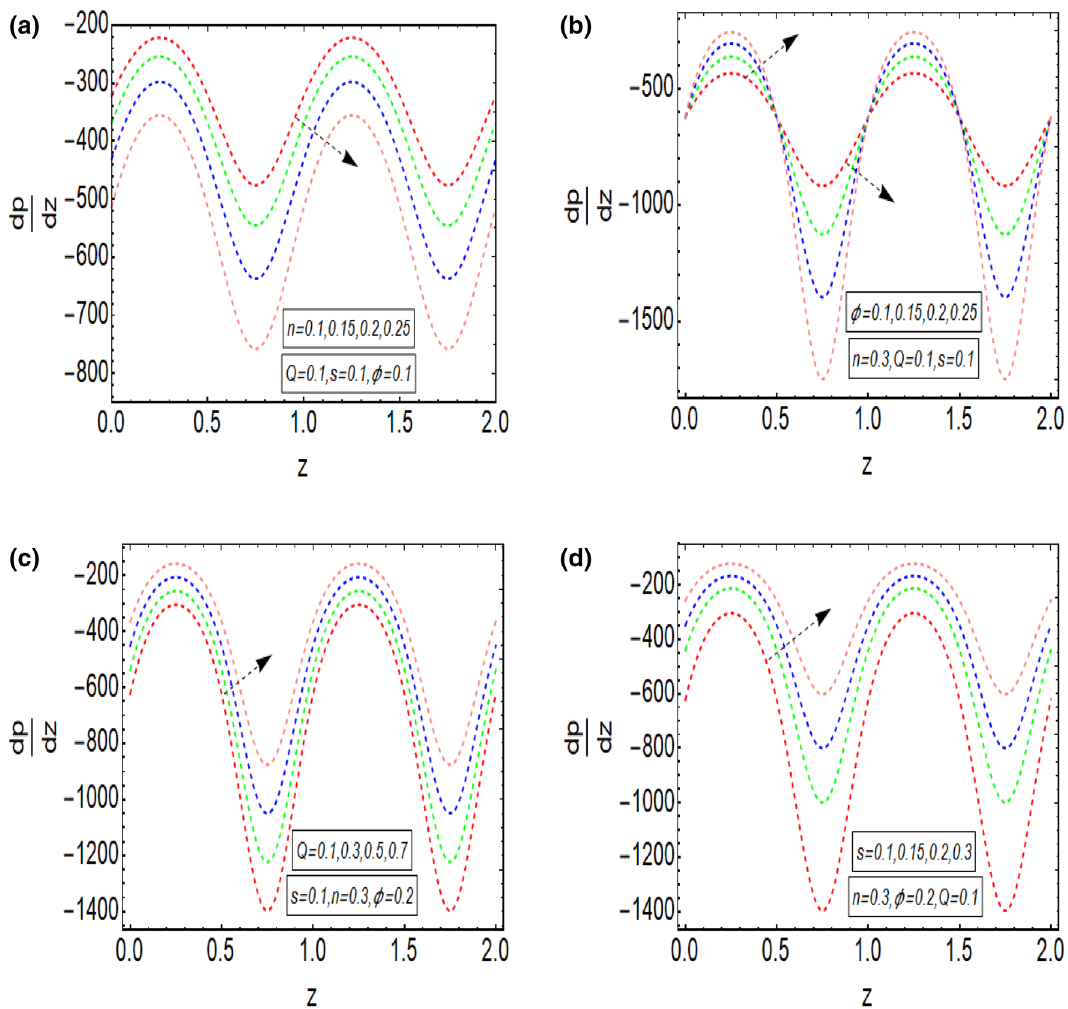
Figure 3. ( a ) dp dz plot for four values of n . ( b ) dp dz plot for four values of φ . ( c ) dp dz plot for four values of Q . ( d ) dp dz plot for four values of s .